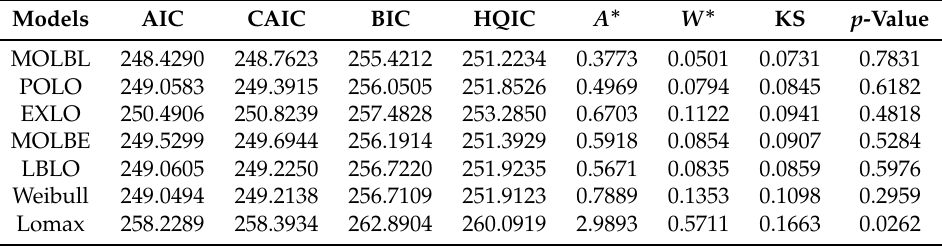
Table 10. Some criteria and goodness of fit measures for Data set